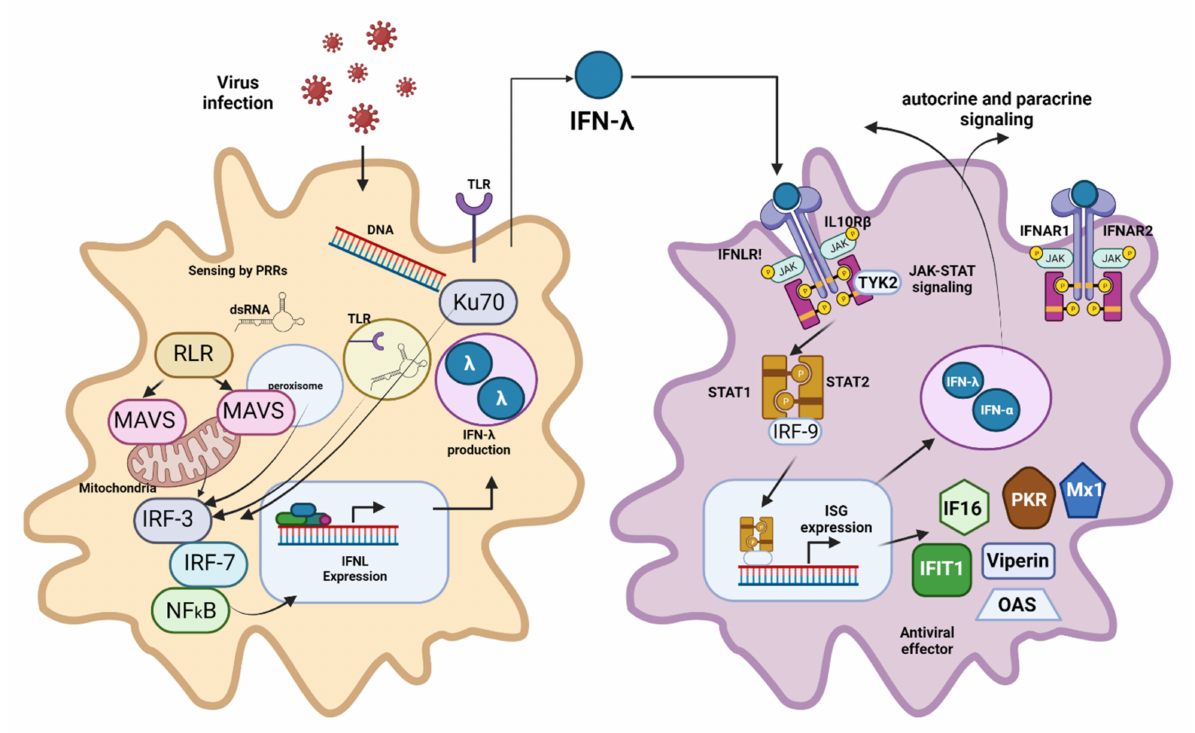
Figure 3. Type III Interferons Production and Activity. Type III IFNs act on epithelial cells and tissue-resident neutrophils, dendritic cells, macrophages, B cells, and plasmacytoid dendritic cells. Like the type I IFN pathway, IFN- λ induction starts with PRR (TLR and RLR) recognition of the respective PAMPs. Receptor-ligand binding triggers the IFN- λ induction cascade via NF κ ß, resulting in the activation and translocation to the nucleus of IFN regulatory factors IRF3 and IRF7, which induce the expression of type III IFN. After its release to the extracellular milieu, IFN- λ binds to its heterodimeric receptor (IFNLR), which consists of two subunits: α -subunit (IL28RA) and β -subunit (IL10RB). IFN- λ -IFNLR trimeric complex formation leads to the activation of JAK1 and TYK2, followed by the phosphorylation of STAT1 and STAT-2. Afterward, STAT1 and STAT-2 translocate to the nucleus and induce the expression of hundreds of ISGs with antiviral activity. Type I and III IFNs both show a complex mechanism of feedback loops, leading to autocrine and paracrine signaling. Even though epithelial cells are the primary source of type III IFN, macrophages, monocytes, and dendritic cells can also secrete them. Created with